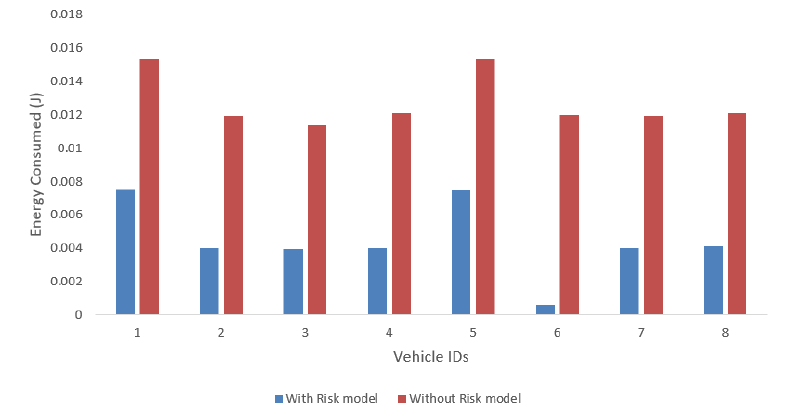
Figure 9. Energy analysis per vehicle.